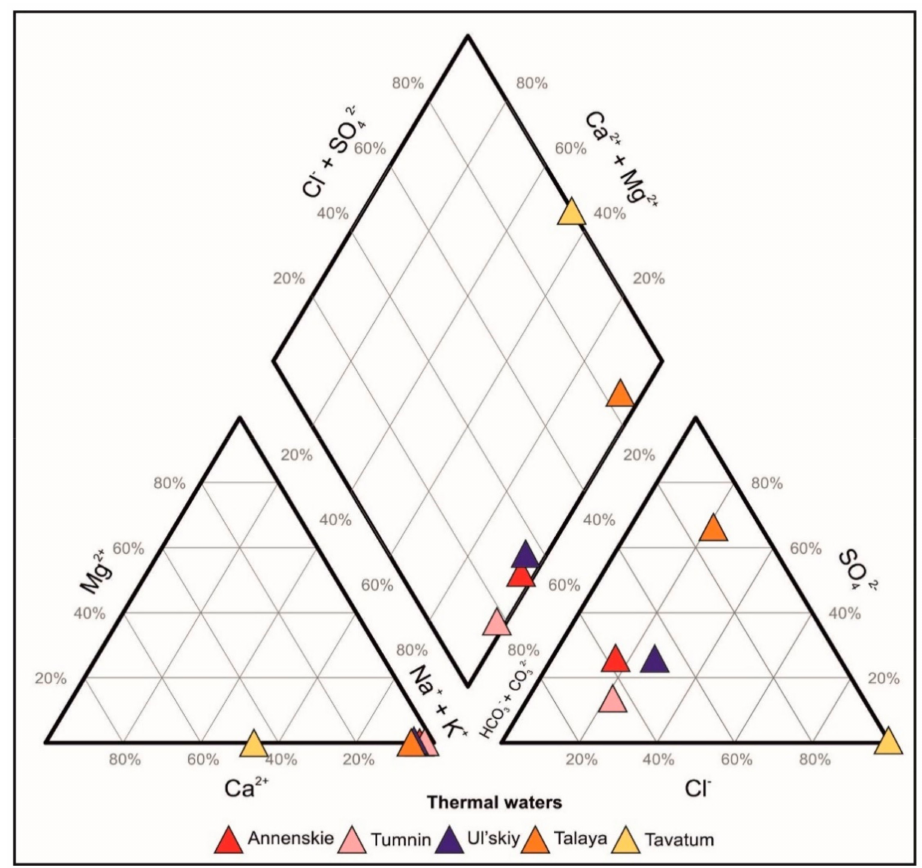
Figure 3. The Piper diagram for the Okhotsk Sea Coast thermal